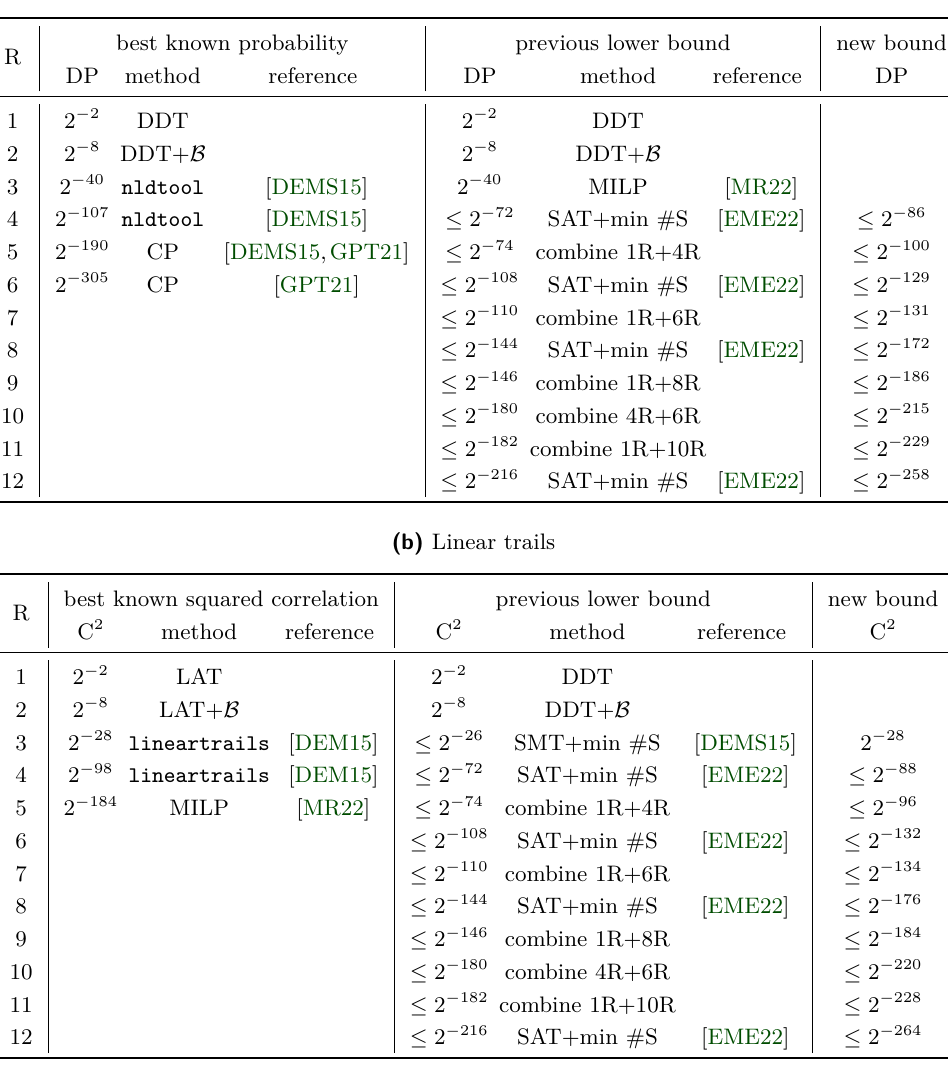
Table 1: Previous and new bounds for the differential probability (DP) of differential trails and squared correlation (C 2 ) of linear trails in Ascon . R denotes the number of rounds; min #S denotes the minimum number of active